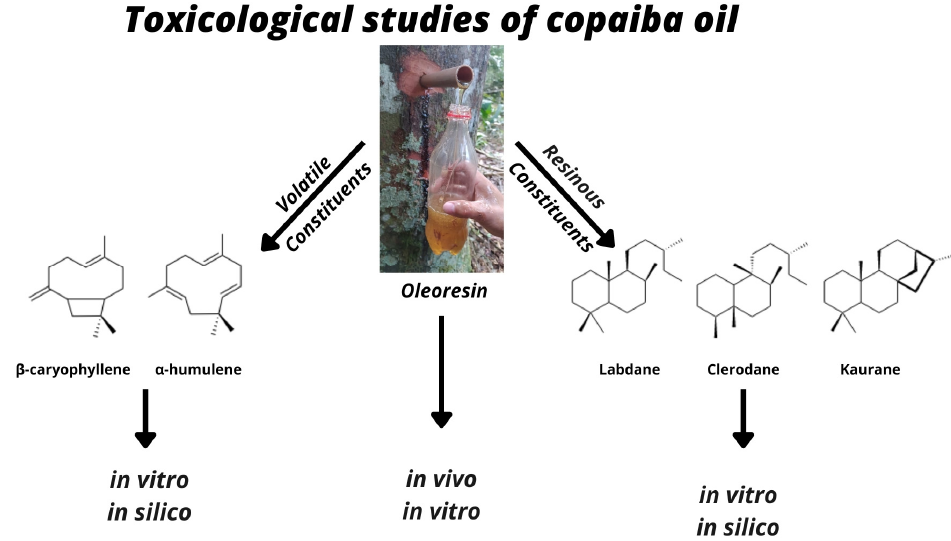
Figure 1. Toxicological studies of oleoresins and substances isolated from Copaifera spp.